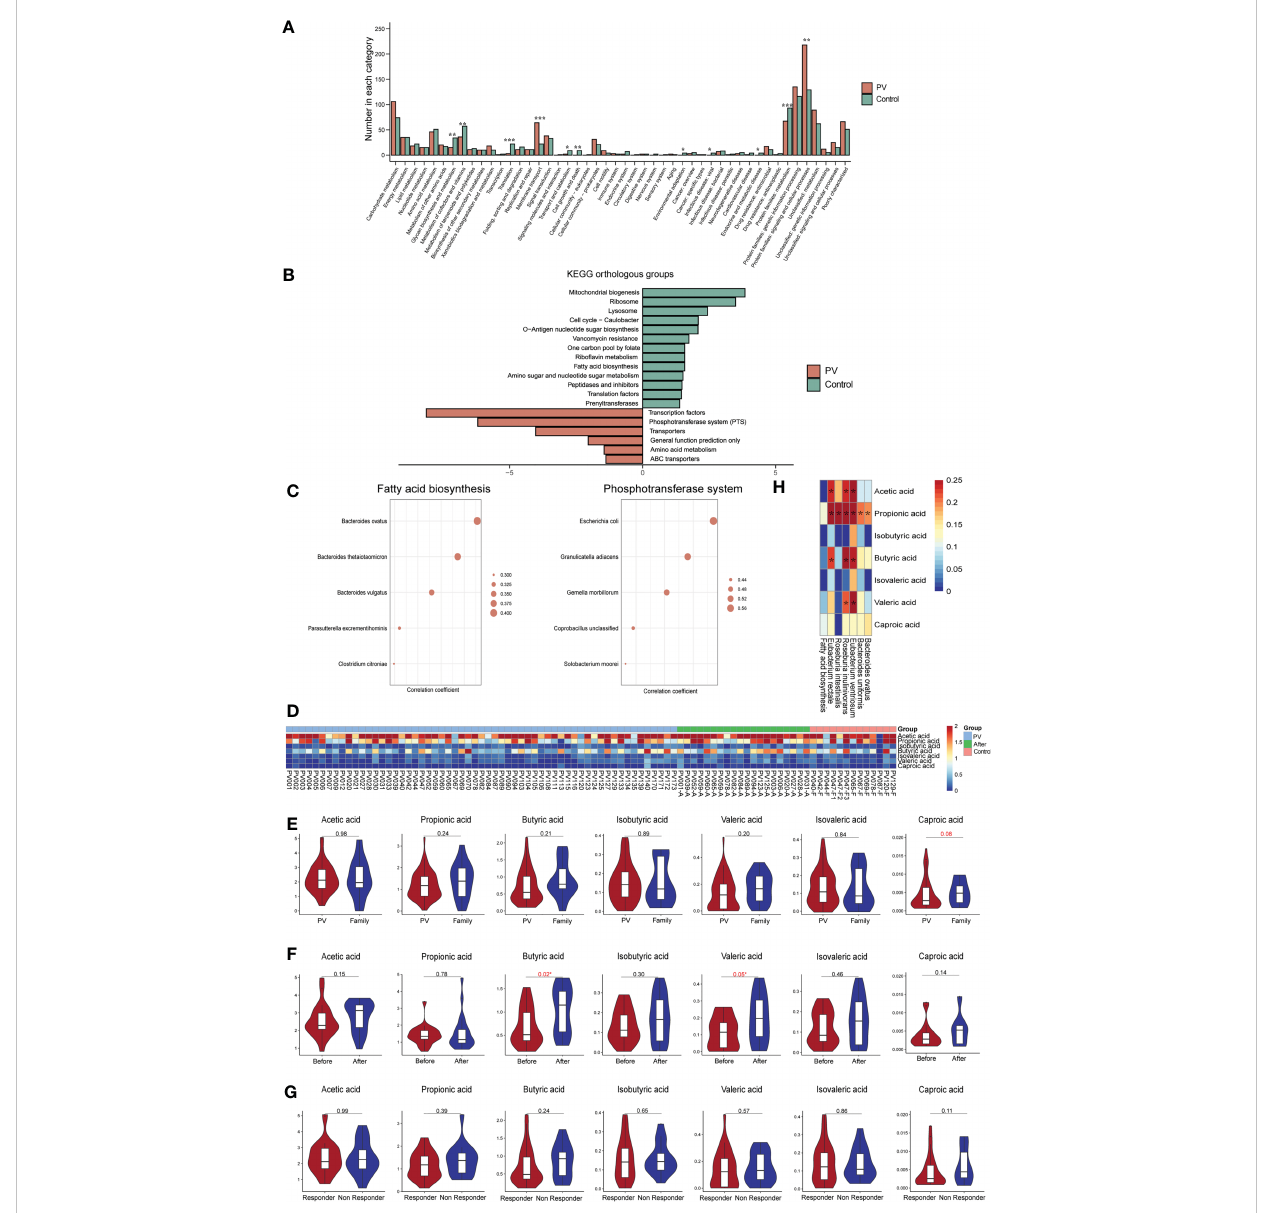
FIGURE 4 Functional changes in the gut microbiome. (A) Level B differential KEGG pathways, horizontal coordinates represent pathway names, vertical coordinates represent the number of differential KOs involved in each pathway (*represents a P value less than 0.05, **represents a P value less